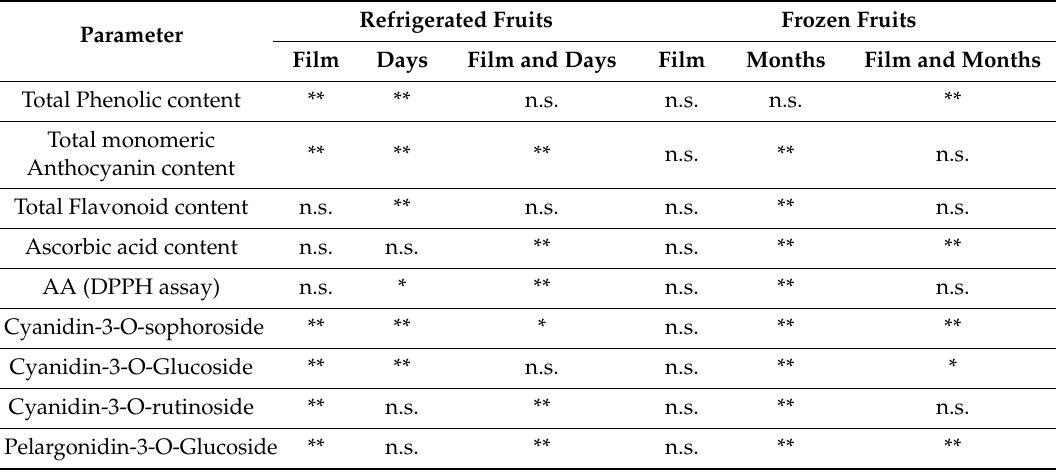
Table 10. Variance analyses on the di ff erent parameters, taking into consideration film e ff ect, day or